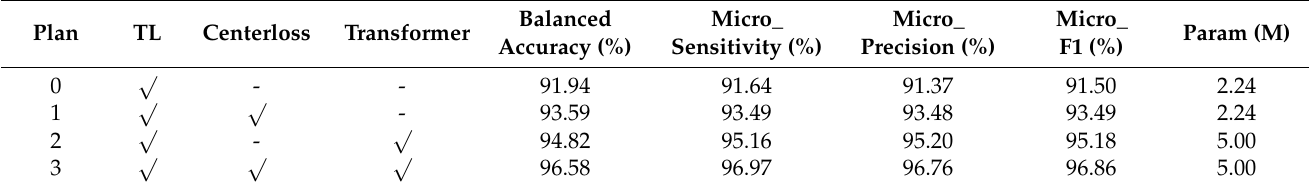
Table 4. The results of ablation studies on Dataset1. The Plan column represents the different experimental models in the ablation experiment. Plan 0 represents the basic model MobileNet-V2. TL stands for transfer learning. Param represents parameter quantity. ‘-’ indicates that this improvement √ is not added; ‘ ’ indicates adding this